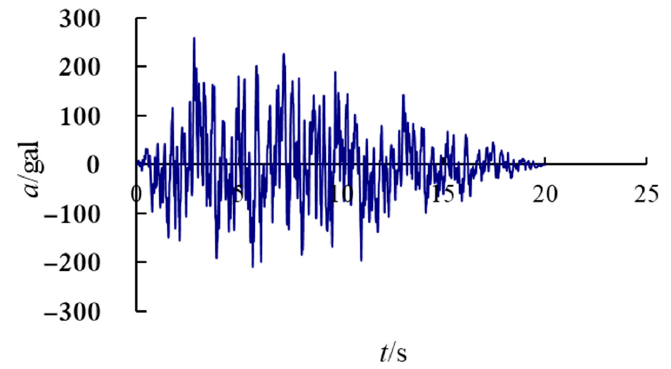
Figure 7. Seismic waves adopted in this study.